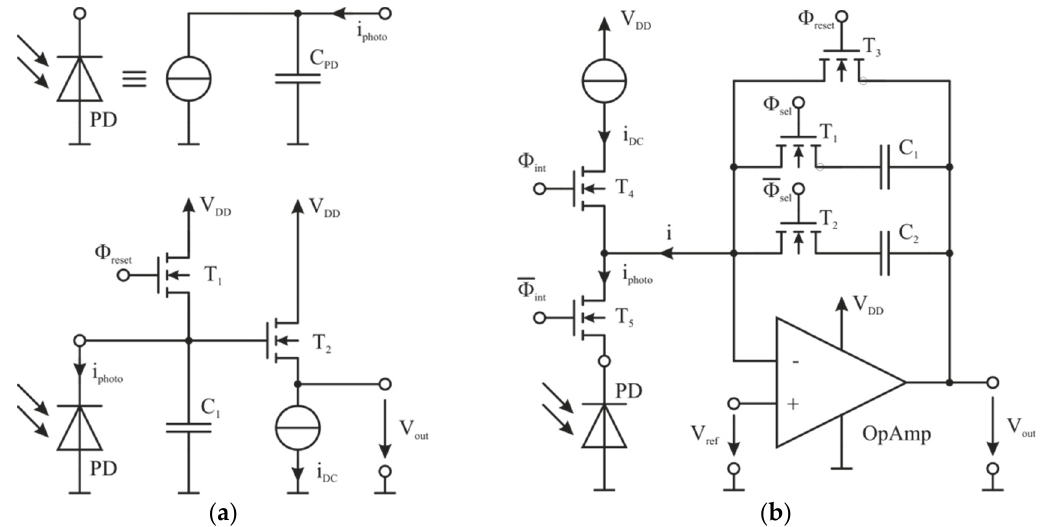
Figure 3. Integration stages: ( a ) passive and ( b ) active dual slope integration.